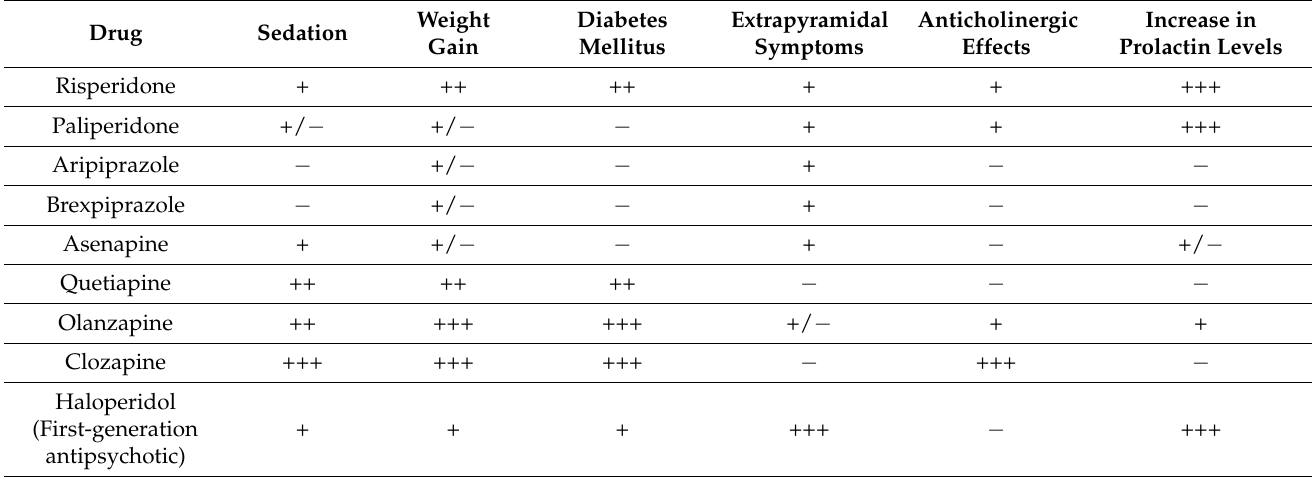
Table 3. Comparison of adverse events to selected second-generation antipsychotics